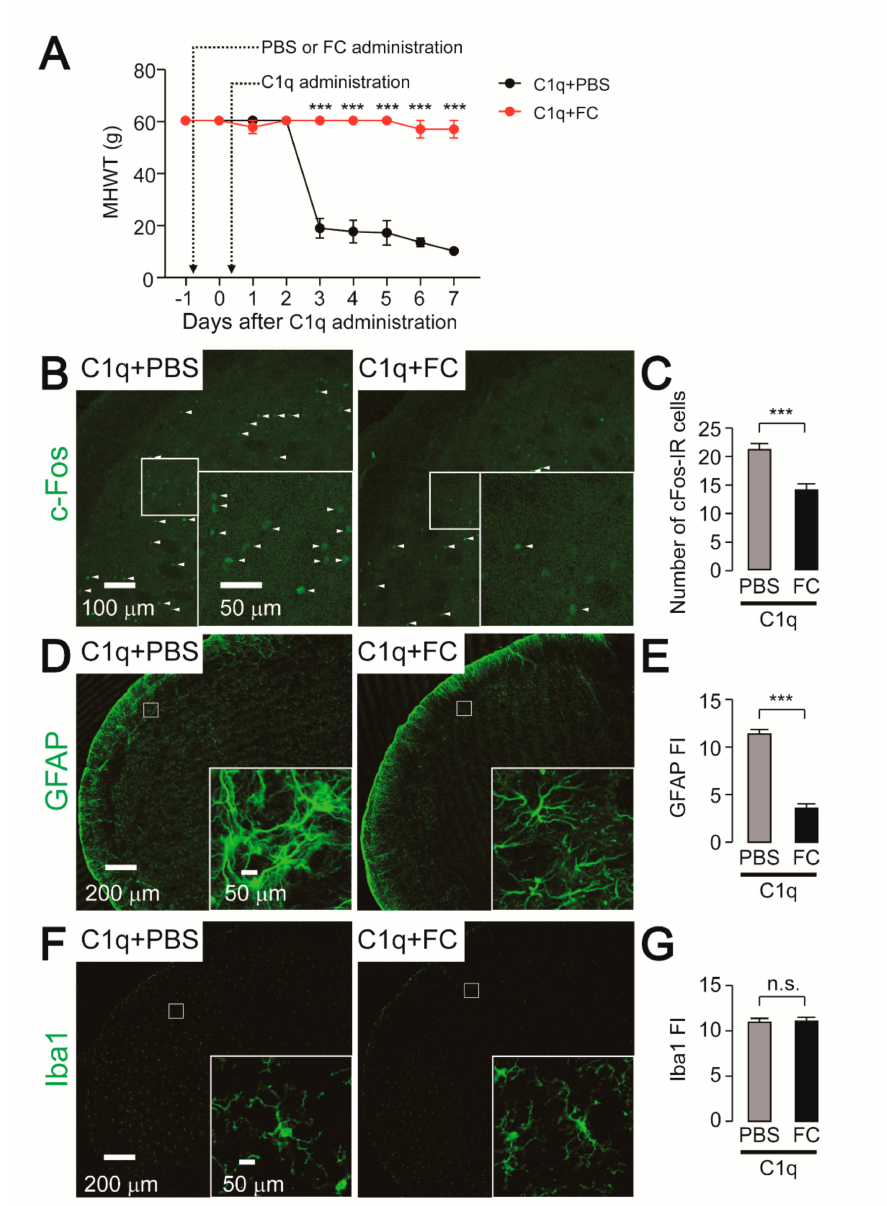
Figure 7. Inhibitory e ff ects of FC on C1q-induced mechanical hypersensitivity and astrocytic activation. ( A ) Time-course of mechanical head withdrawal threshold (MHWT) in the whisker pad skin. C1q + PBS: n = 5, C1q + FC: n = 5, two way ANOVA post hoc Bonferroni test, *** p < 0.001 (vs. C1q + PBS-treated group). ( B , D , F ) Representative images of c-Fos ( B ), GFAP ( D ), and Iba1 ( F ) immunofluorescence in the Vc 7 days after C1q + PBS or C1q + FC administration. Arrowheads indicate c-Fos-IR neurons. Insets indicate enlarged images of the region indicated in the open square. ( C , E , G ) Averaged number of c-Fos-IR cells ( C ) and fluorescence intensity (FI) of GFAP ( E ) and Iba1 ( G) in the Vc on day 7 of C1q + PBS or C1q + FC-administrated rats. C1q + PBS: n = 5, C1q + FC: n = 5, unpaired Student’s t -test, *** p < 0.001. n.s.: not significant. The data represent the means ±